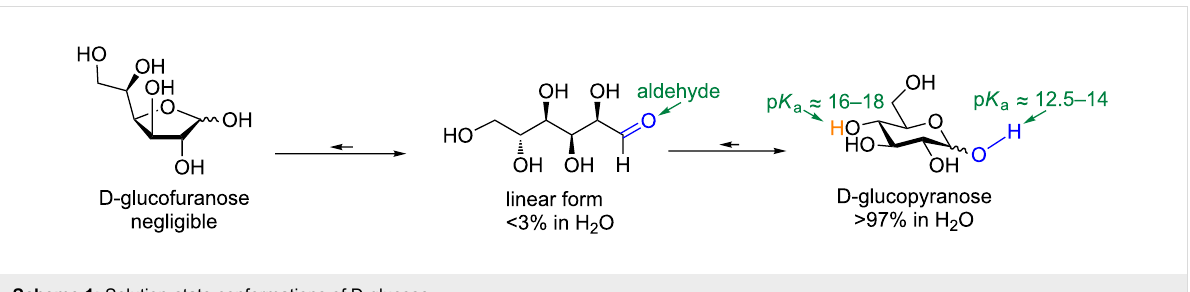
Scheme 1: Solution-state conformations of